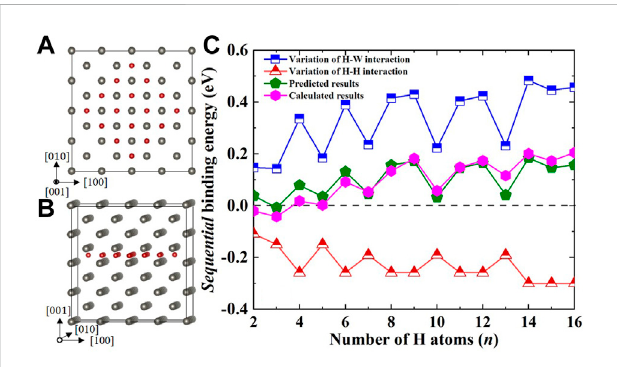
FIGURE 1 (A) The top and (B) the side views of the most stable planar H 2~16 cluster in W along (001) planes. The small red and large grey balls represent H and W atoms, respectively; (C) shows the calculated and predictedsequentialbindingenergiesofplanarHclusters,basedon the linear elasticity model of Eq. 3 and the repulsive interactions of H-H